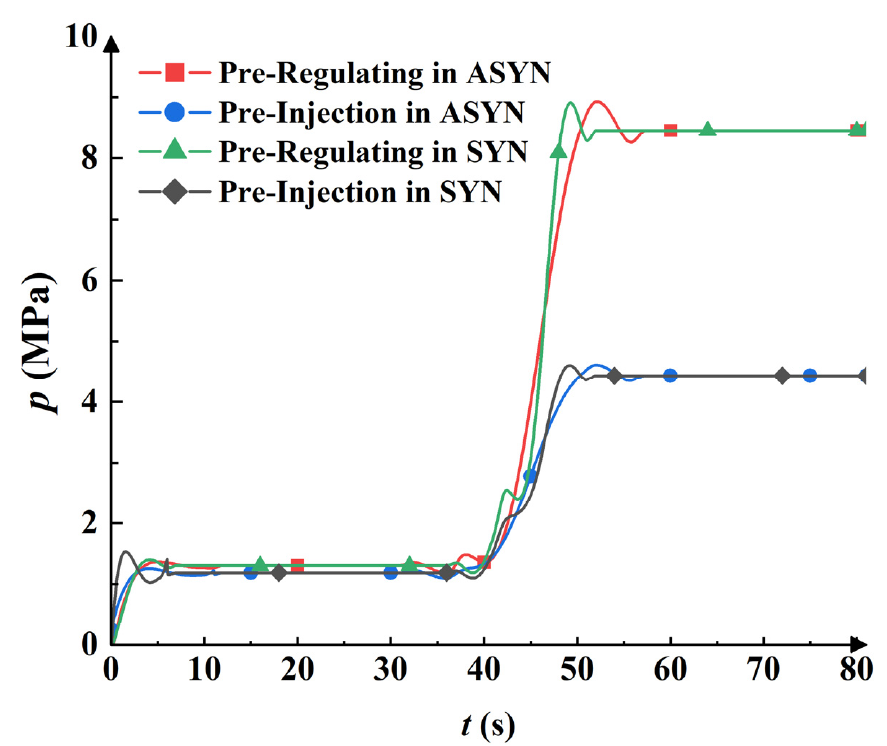
Figure 9. Comparison of pre-regulating and pre-injection pressure in Scheme ASYNC vs. Scheme SYNC.